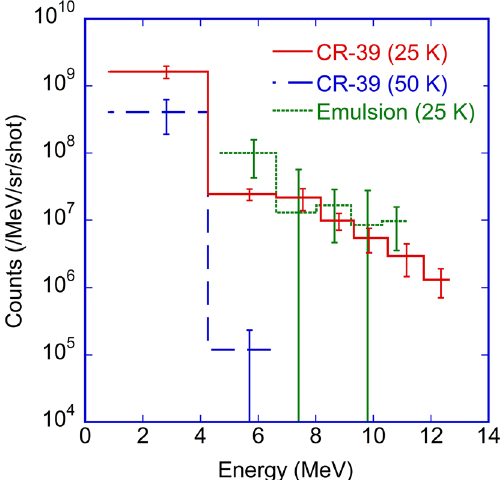
Figure 2. Energy spectra of laser-accelerated protons. The energy spectra measured using integration-type ion detector unit with the CR-39 plate at nozzle temperatures of 25 K (red solid line) and 50 K (blue broken line). The energy spectrum measured with the stack of nuclear emulsion films at the nozzle temperature of 25 K (green dotted line) is also shown as reference data 50 . The error bars on the ordinates represent the